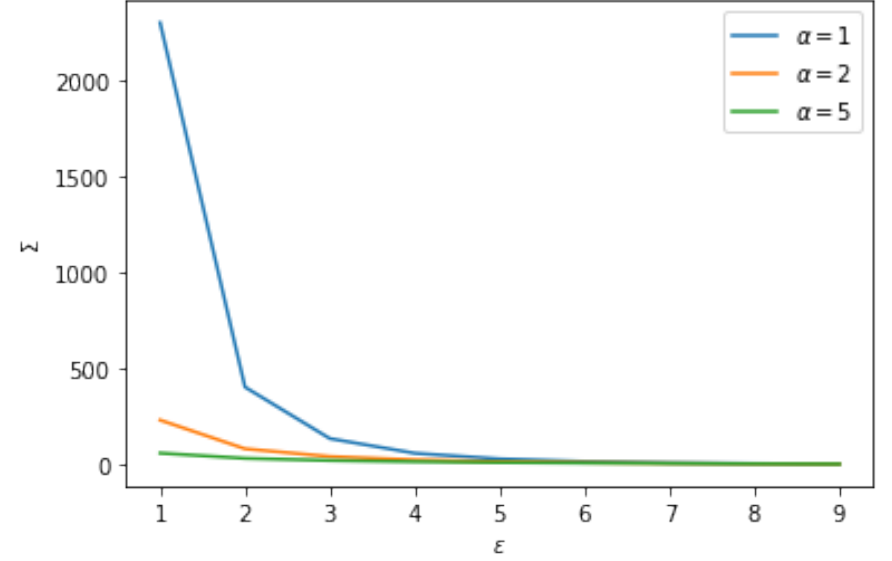
Figure A1. The upper bound on the network sparsity, | θ | 0 ≤ Σ , as a function of the error tolerance (cid:101) and Hölder smoothness, α , of the function being approximated. As (cid:101) or α decrease, the value of Σ is observed to increase. The plot is shown for i = 2 and Σ 0 =